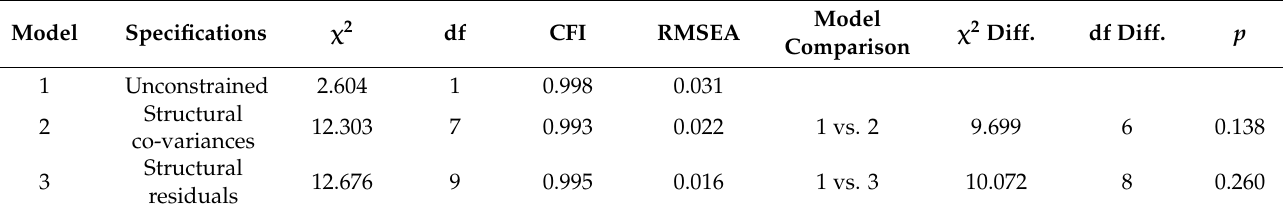
Table 6. Multi-group analysis: males vs. females.